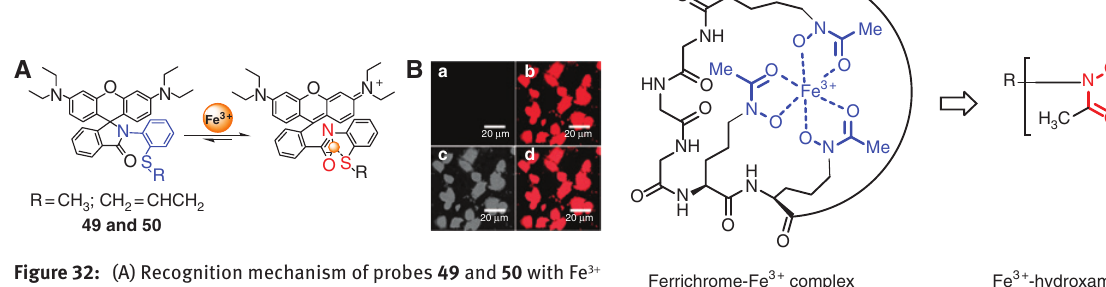
Figure 32: (A) Recognition mechanism of probes 49 and 50 with Fe 3 + and (B) confocal fluorescence and bright-field images of HepG2 cells (scale bar, 20 mm). Reprinted from Yang et al. (2015). Figure 33: Ferrichrome-Fe 3 + complex and Fe 3 + -hyroxamate